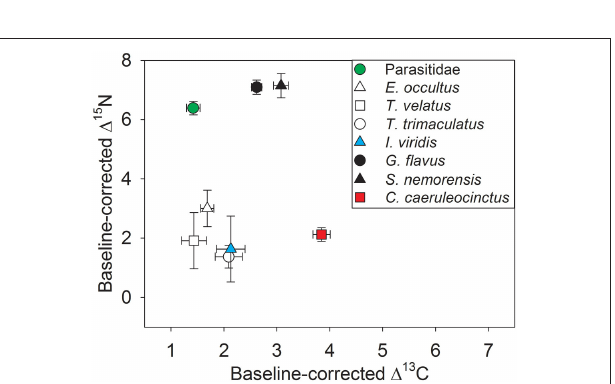
FIGURE 4 | Carbon and nitrogen stable isotope ratios (means ± SE) for soil arthropod species with the stable isotope signature of plant samples at each site used as local baseline ( 1 values). The closer an average 1 value ( 13 C or 15 N) is to zero on the carbon or nitrogen axis the less enriched the respective species is compared to isotopic values of plant samples from the same sampling site. For sample sizes see Table 1 .